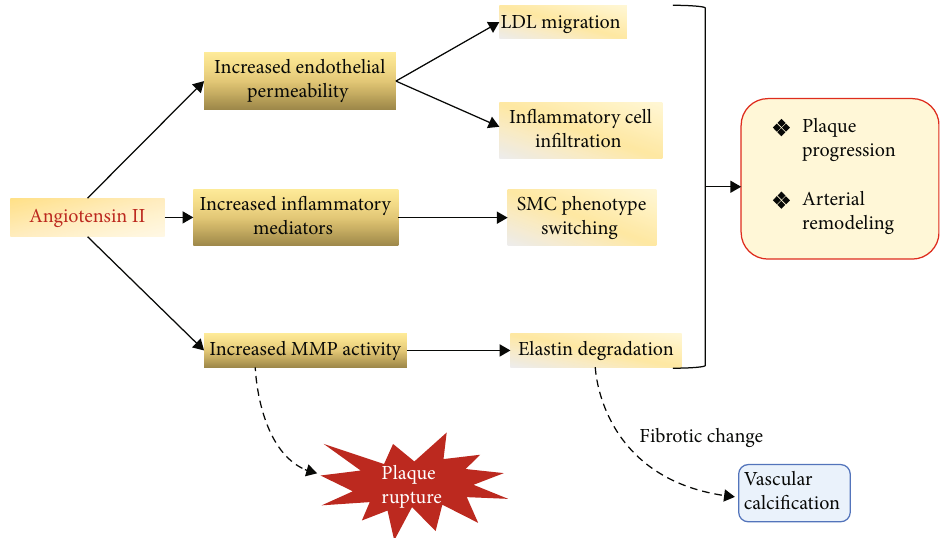
Figure 2: Angiotensin II role in atheromatous plaque modulation (LDL: low-density lipoprotein; MMP: matrix metalloproteinase; SMC: smooth muscle